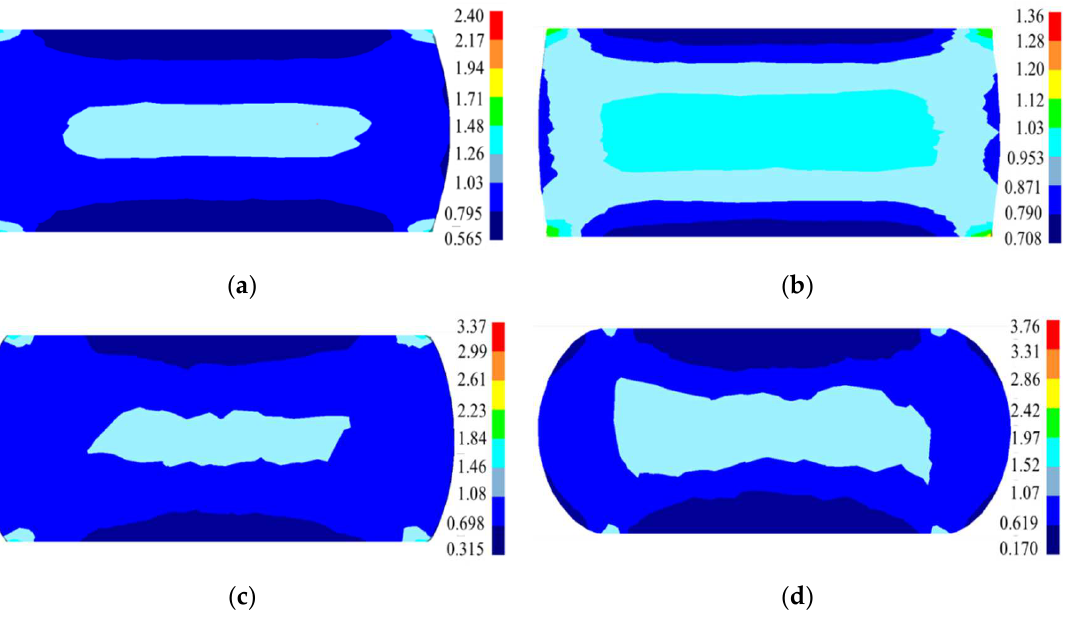
Figure 21. The equivalent plastic strain at ( a ) 1110 °C/0.1 s −1 ; ( b ) 1140 °C/0.1 s −1 ; ( c ) 1110 °C/0.01 s −1 ; and ( d ) 1110 °C/1 s −1 .